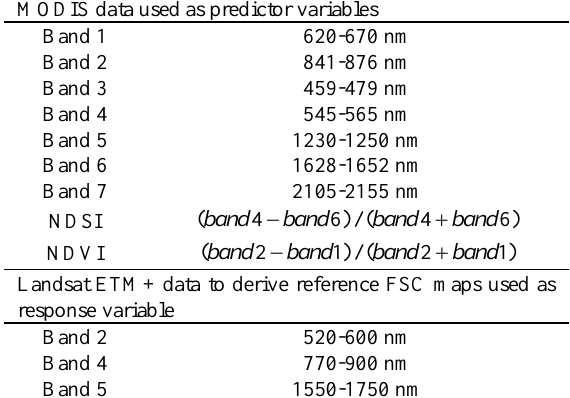
Table 2: MODIS and Landsat ETM+ data used in ANN and SVM models.